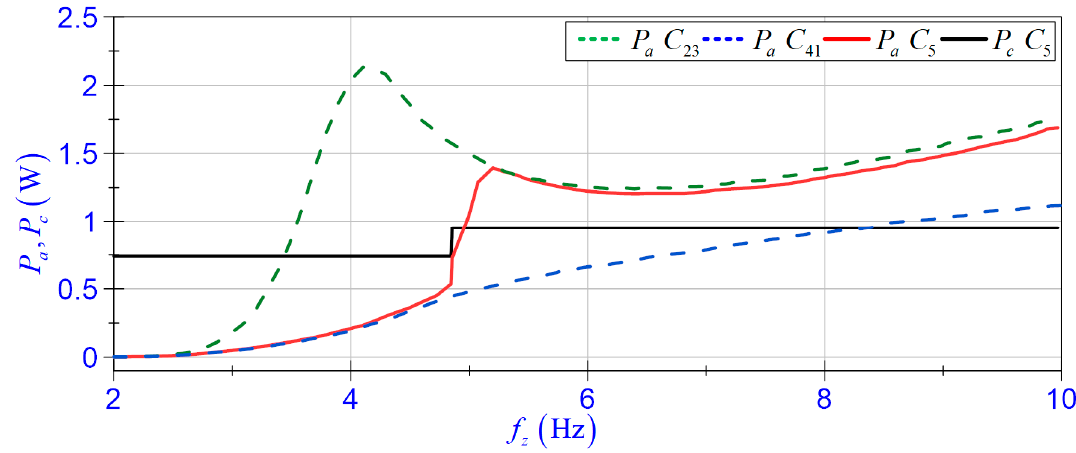
Figure 20. Active power P a and consumed power P c vs. frequency f z